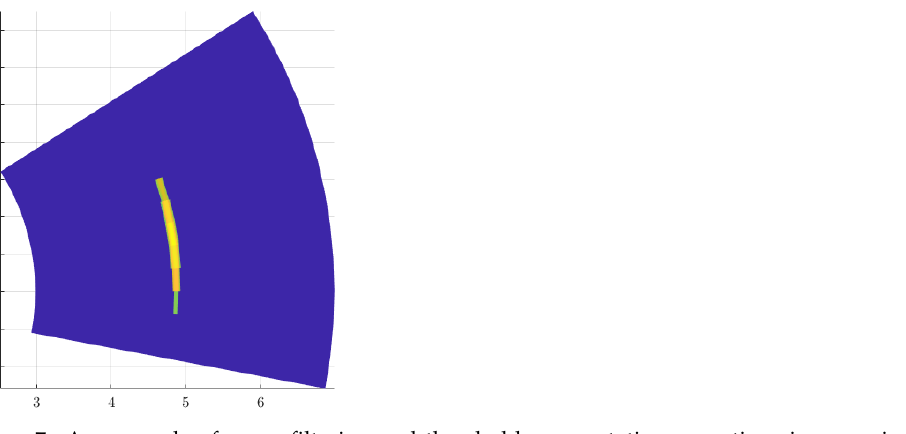
Figure 7. An example of mean filtering and threshold segmentation operations in sonar image processing. Due to the application of the mean filtering method before threshold segmentation, removing false positives related to reflections and noise have been achieved. The example above shows the importance of pre-processing operations for better image processing results.[own source].